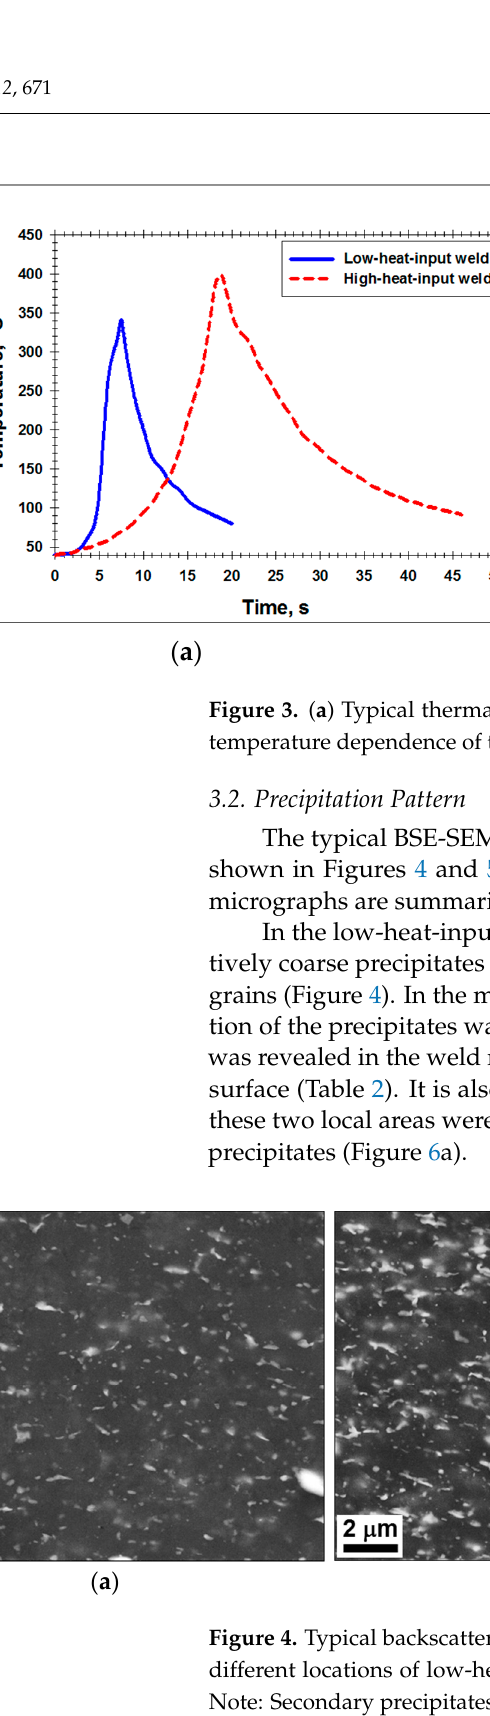
(c) Figure 5. Typical backscatter-electron-scanning electron microscopy (BSE-SEM) images taken from different locations of high-heat-input weld: ( a ) upper surface, ( b ) weld nugget, and ( c ) weld root. Note: Secondary precipitates appear bright. ( a ) ( b ) Figure 6. The precipitate-size distributions measured in different locations of ( a ) low-heat-input weld and ( b ) high-heat-input weld.